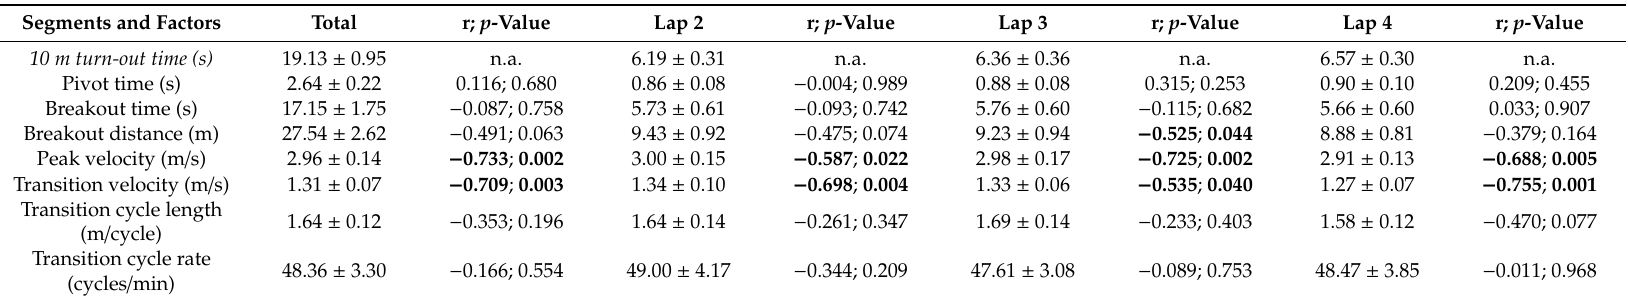
Table 6. Descriptive statistics (mean ± standard deviation) and correlation analysis of the 10 m turn-out segment time with underlying components. Segments and Factors